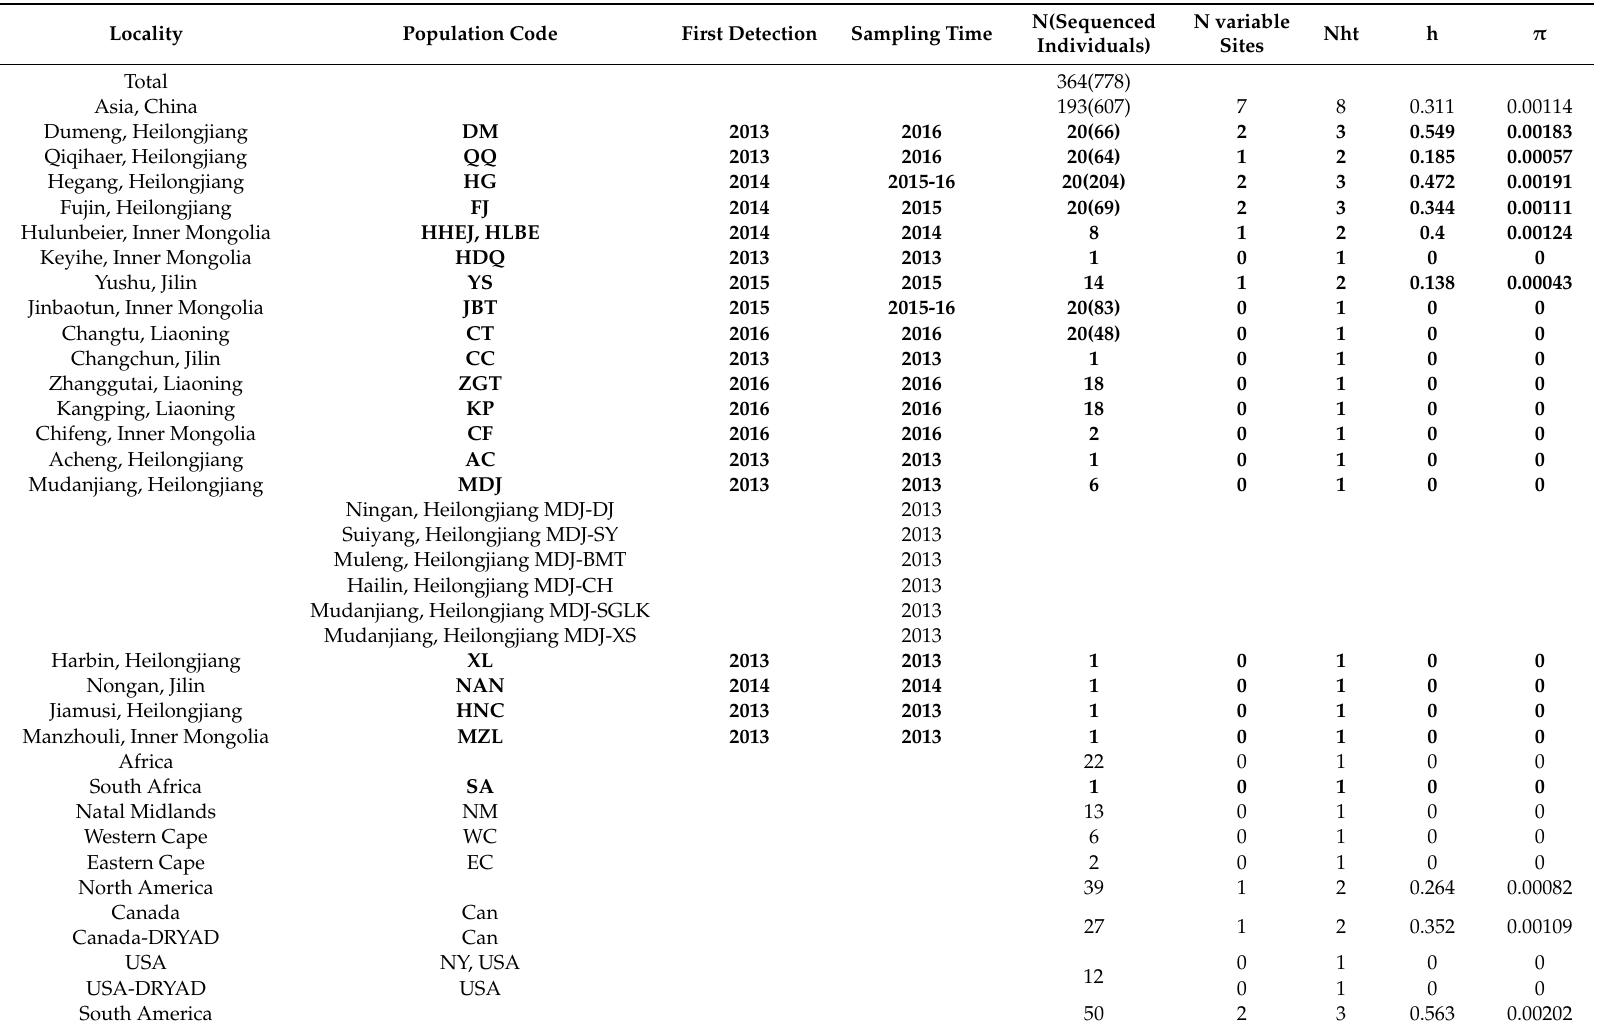
Table 1. Summary of sampling sites and common parameters of genetic diversity of Sirex noctilio analyzed in this study.